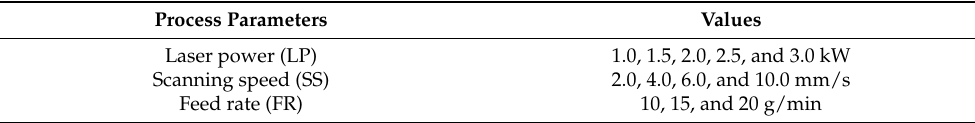
Table 2. Process parameters tested for M625 deposition on 42CrMo4 substrate. Process